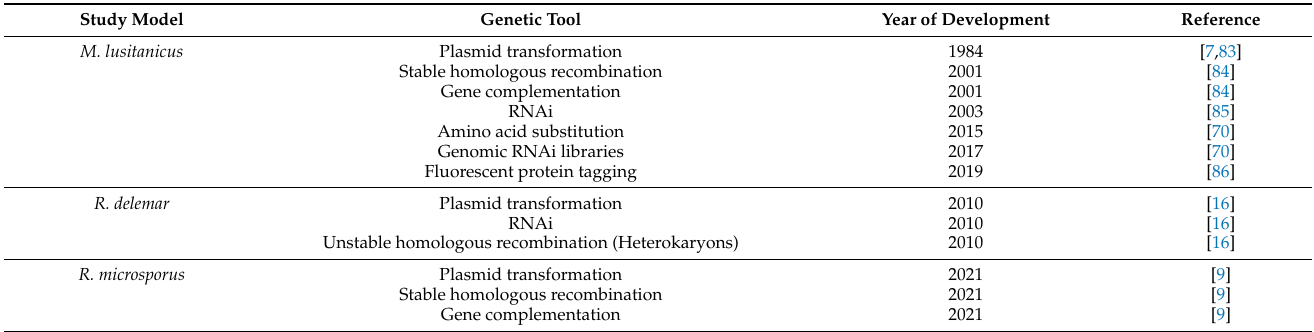
Table 2. Main genetic tools in Mucorales